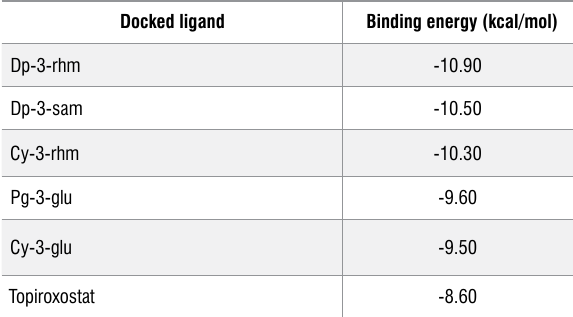
Binding energies of the anthocyanin–XO and topiroxostat– XO complexes Docked ligand Binding energy (kcal/mol)